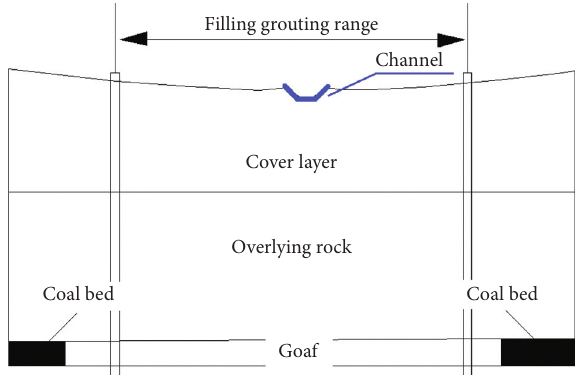
Figure 3: Filling range in